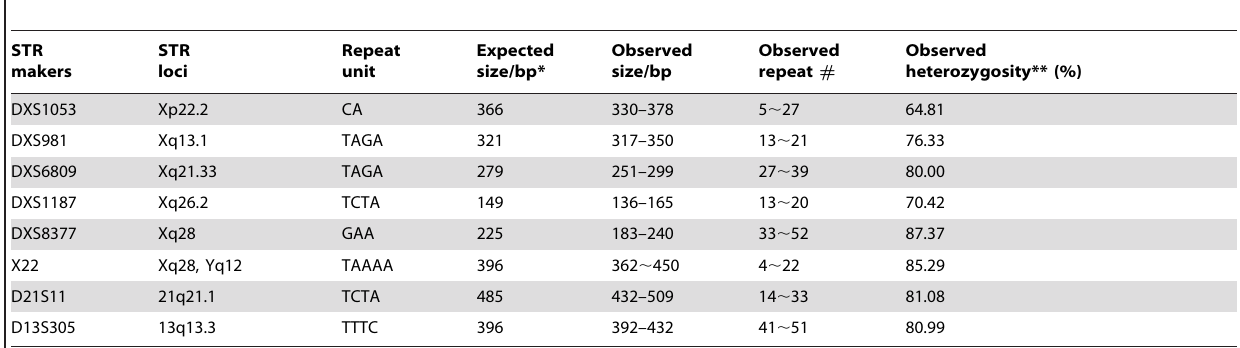
Table 3. Heterozygosity and repeat numbers of the selected STR markers in the tested Chinese Han population.